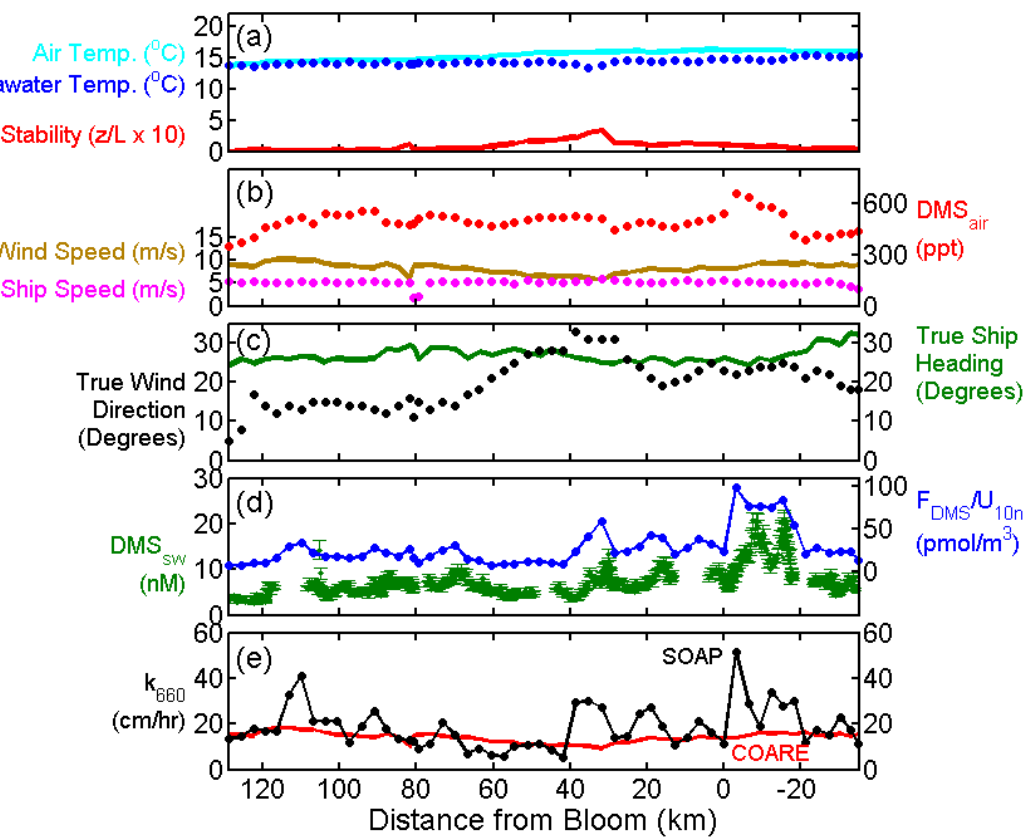
Figure 7. Shipboard measurements during the south–north transect into B1. The data are plotted as a function of distance from the southern perimeter of the bloom. Symbols represent 10min averages, with the exception of 1min average seawater DMS concentrations (d) . The red line in (e) is the COARE model output for DMS, shown for